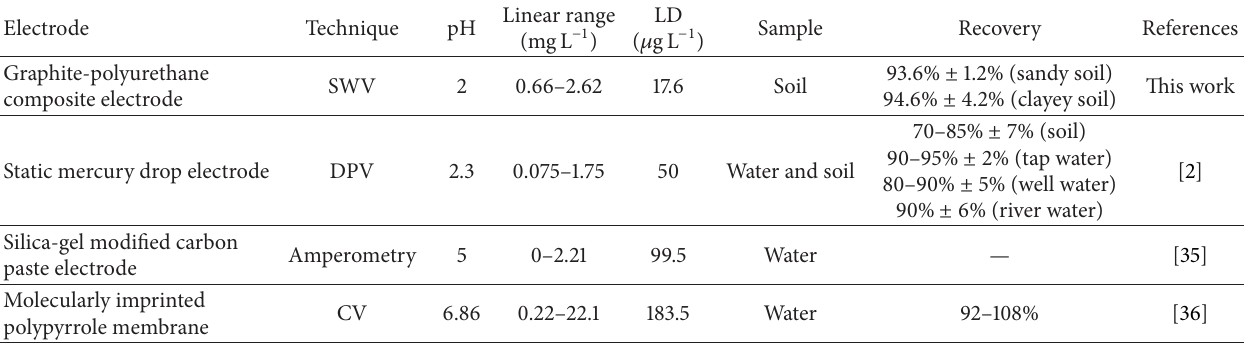
Table 1: Comparison between the proposed electroanalytical methodology and other ones already published in the literature for the detection of 2,4-D.